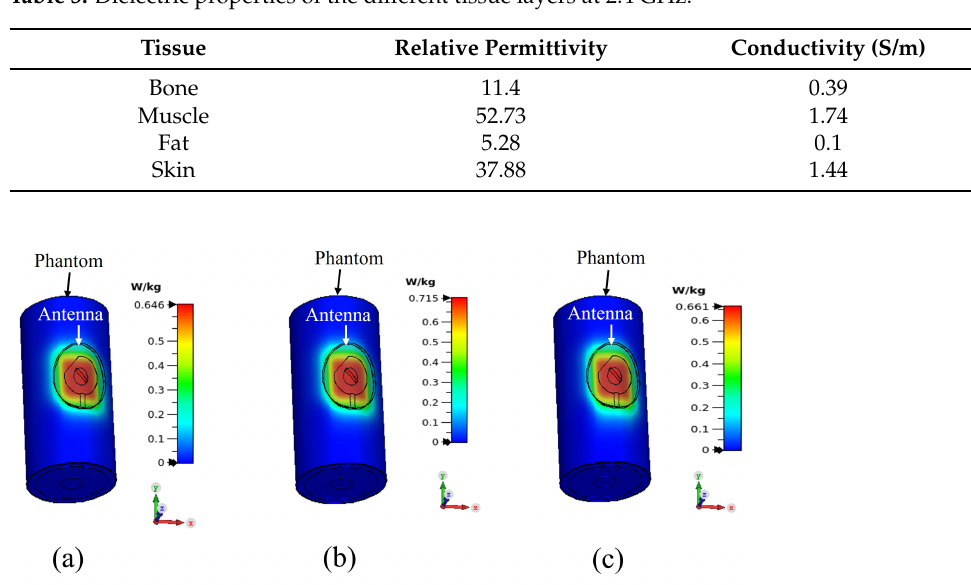
Figure 19. Antenna on top of the multilayer phantom: ( a ) cross-sectional view, ( b ) perspective view. (R bn = 12.5 mm, R ms = 40 mm, R ft = 48.5 mm, R sk = 50 mm). Table 3. Dielectric properties of the different tissue layers at 2.4 GHz.